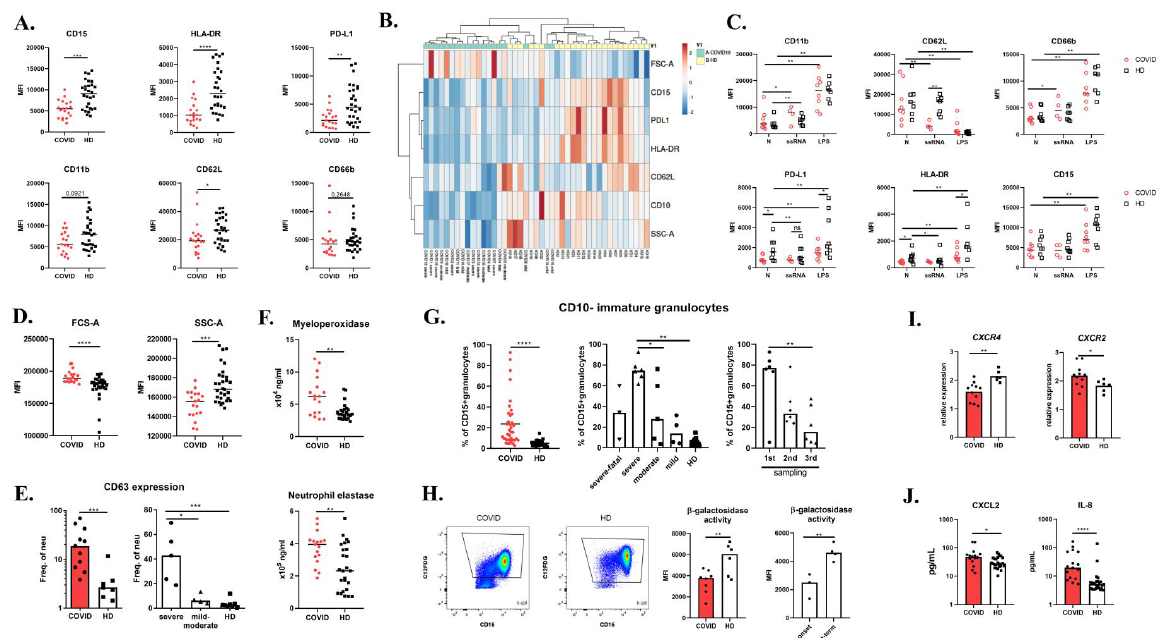
Figure 1. Neutrophils in COVID-19. ( A ) Peripheral blood neutrophil phenotype of 19 COVID-19 patients upon the hospital administration and 28 healthy donors (HD) was assessed by flow cytometry. ( B ) Cluster analysis of neutrophil phenotype; both rows and columns are clustered using correlation distance and average linkage. ( C ) Expression of CD11b, CD62L, PD-L1, HLA-DR, CD66b, and CD15 was analyzed in peripheral blood stimulated with 10 µ g / mL ssRNA for 240 min, 1 µ g / mL LPS for 30 min, or left untreated in 8 COVID-19 patients and 8 HD. ( D ) Forward Scatter (FSC-A) and Side Scatter (SSC-A) of neutrophils were analyzed in 19 COVID-19 patients and 28 HD. ( E ) CD63 expression on the peripheral neutrophil surface was analyzed in 11 COVID-19 patients and 7 HD using flow cytometry. ( F ) Serum levels of myeloperoxidase and neutrophil elastase were analyzed in 17 COVID-19 patients and 25 HD by ELISA. ( G ) Immature granulocytes were distinguished in peripheral blood by utilizing CD10 marker. CD10-CD15 + CD66b + immature neutrophils were analyzed in 19 COVID-19 patients and 28 HD by flow cytometry. The population was analyzed in three di ff erent time points during the course of the disease (1–4 weeks). ( H ) β -galactosidase activity in isolated neutrophils was assessed in 7 COVID-19 patients and 6 healthy donors by flow cytometry. ( I ) CXCR4 and CXCR2 expression on isolated neutrophils was analyzed by RT-PCR in 11 COVID-19 patients and 6 HD. Expression was normalized to GAPDH. ( J ) Serum levels of CXCL2 and IL-8 in COVID-19 patients ( n = 17) and HD ( n = 25) were analyzed by ELISA. Statistical analysis was performed using the Wilcoxon paired or Mann–Whitney unpaired t -test. Values of p < 0.05 (*), p < 0.01 (**), p < 0.001 (***), and p < 0.0001 (****) were considered statistically